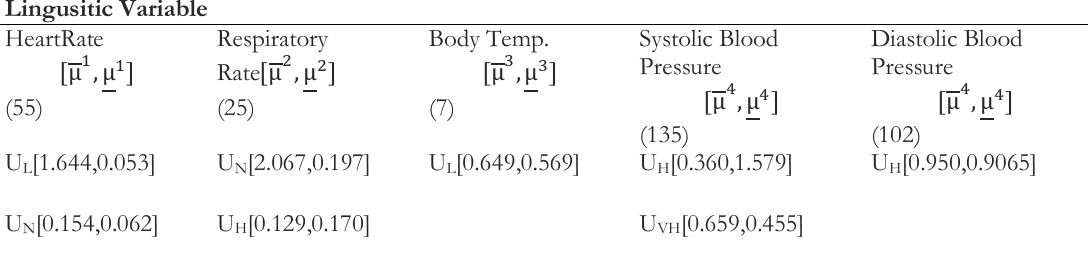
Table 3. Fuzzified value (fuzzy set).